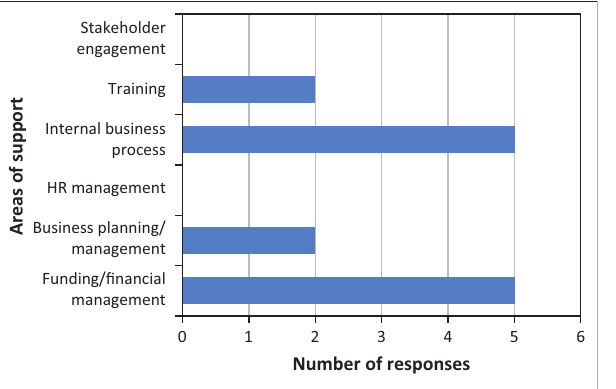
FIGURE 9: Use of cell phone and Internet for